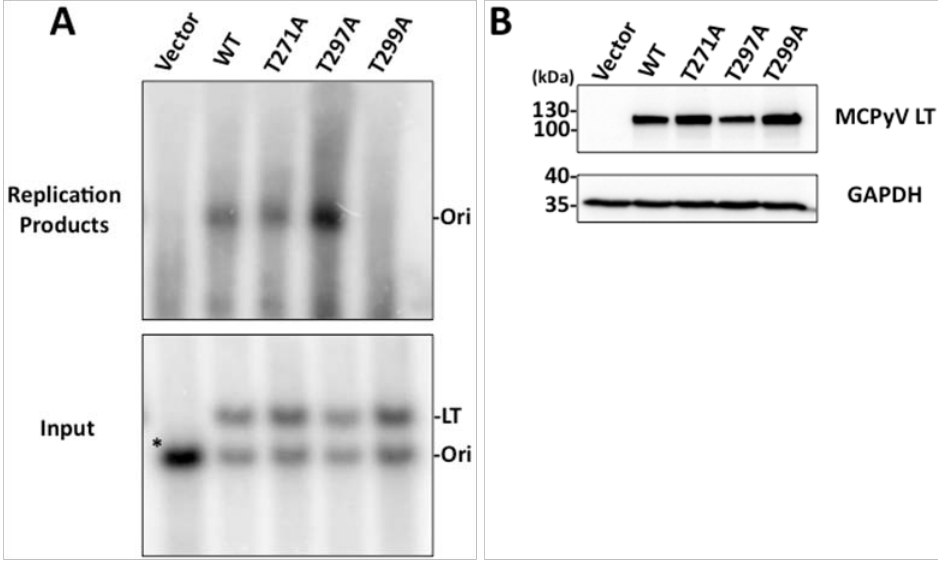
Figure 4. MCPyV LT phospho-mutant proteins replicate plasmids containing the viral Ori to differing degrees. C33A cells were co-transfected with a MCPyV Ori plasmid and the indicated MCPyV phospho-mutant LT. Forty-eight hours post transfection cells were split and extracted for total cellular DNA or total proteins. ( A ) Southern blotting of whole genomic DNA. Both the MCPyV Ori and MCPyV LT plasmids use the same vector backbone and are both recognized by the Southern blot probe. 15 µg of DNA was digested with BamHI and DpnI to detect replicated origin plasmid (Replicated Products, top); replicated Ori plasmid is indicated. 2 µg of DNA was digested with only BamHI to show equal loading (Input, bottom); Ori and LT plasmids are indicated. The vector control plasmid for LT is almost identical in size to the Ori plasmid, causing both plasmids to co-migrate in the blot (asterisk (*), first lane, bottom panel); ( B ) Total protein extracts were western blotted to detect MCPyV LT and GAPDH. Southern and western blots are representative of at least three